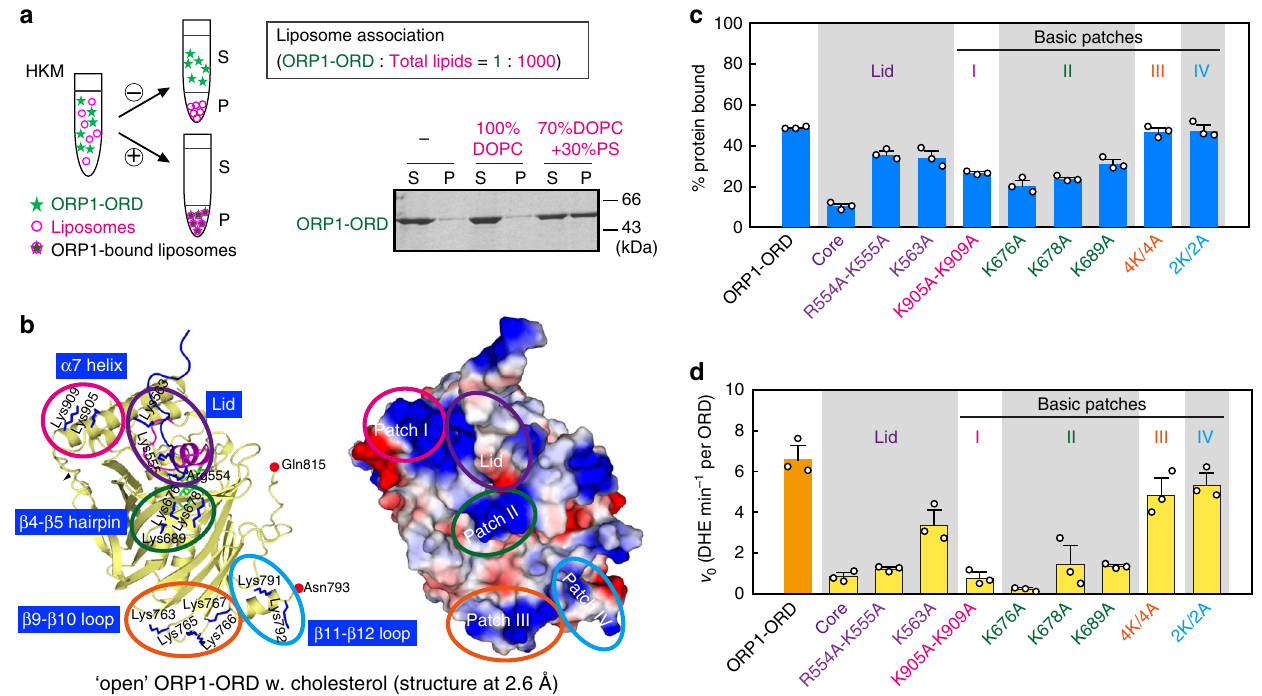
Fig. 7 Key regions for membrane association of ORP1-ORD. a Liposome association assay for ORP1-ORD. b Potential membrane-binding sites on the open ORP1-ORD structure. The surface representation is colored according to electrostatic potential (positive, blue; negative, red), and the lid region and four basic patches are circled. c Bar graph for membrane-bound fractions of basic region mutants to liposome enriched in negatively charged lipids. d Effects of basic region mutations on the initial rates of PI(3,4)P 2 -dependent DHE transport. (For all bar graphs, data are shown as mean ± s.e.m. (error bar), n =